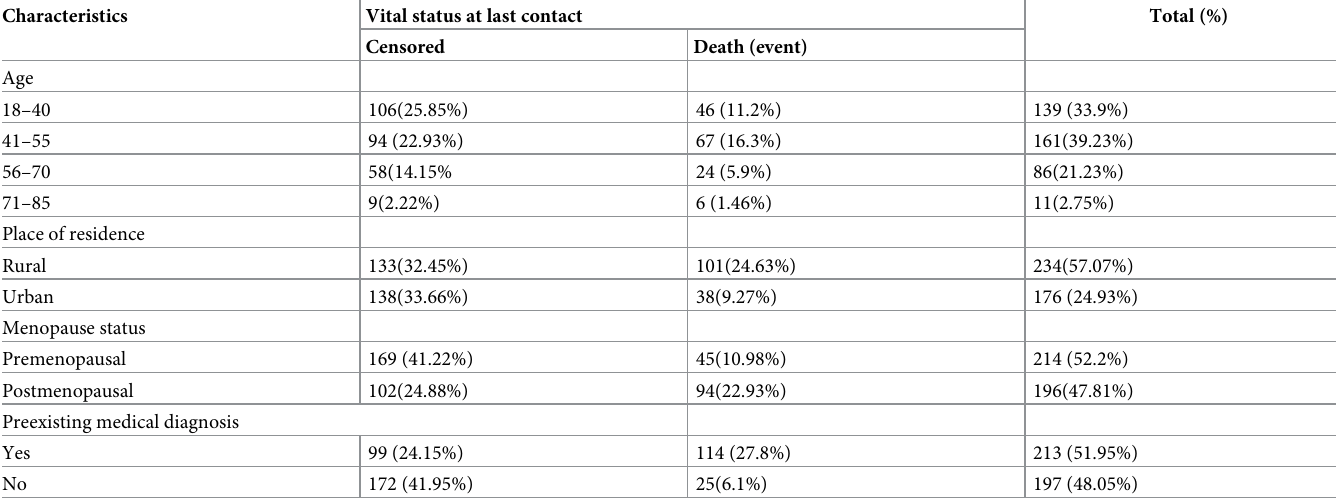
Table 1. Sociodemographic characteristics of the study